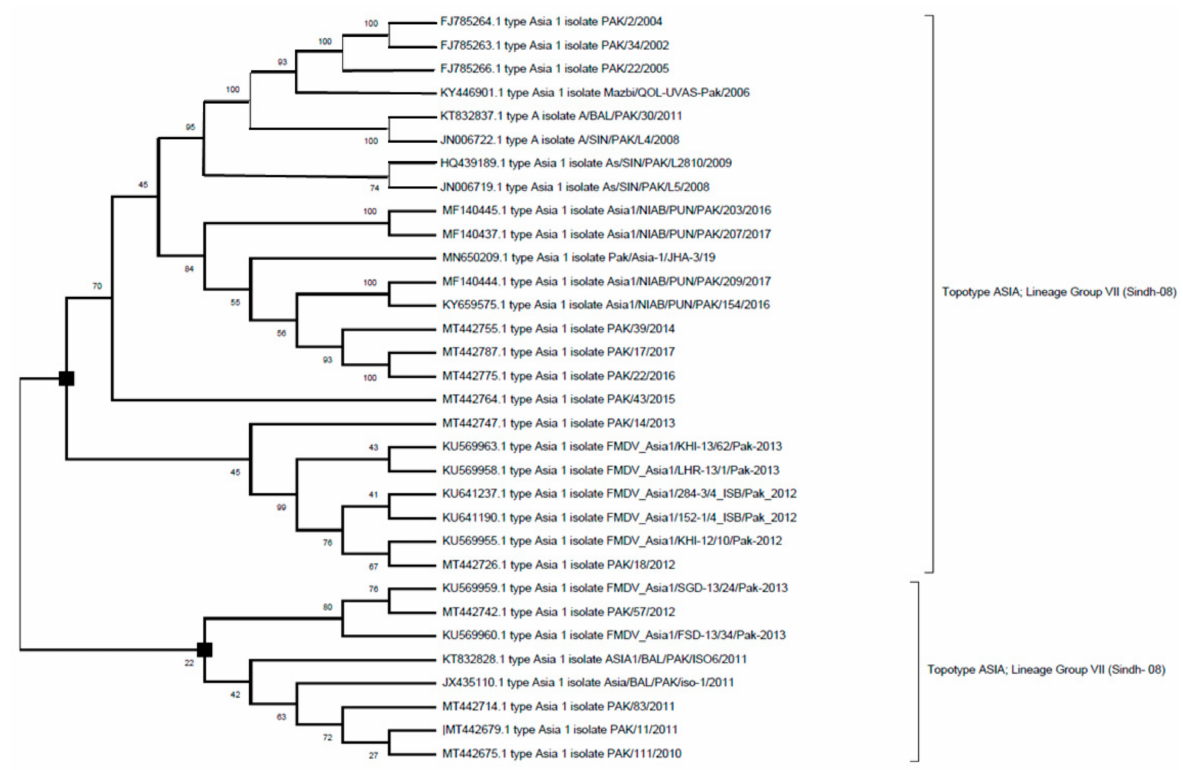
Figure 3. Phylogenetic evolutionary (rooted) tree depicting relationship between FMDV serotype Asia-1 isolates of Pakistan that have been retrieved from GeneeBank. The VP1 region sequences are used for comparison of sequences. The phylogenetic tree was constructed with maximum likelihood method based on Tamura–Nei model. The tree topology robustness was measured with bootstrap values (100 replicates). The values on the nodes show bootstrap